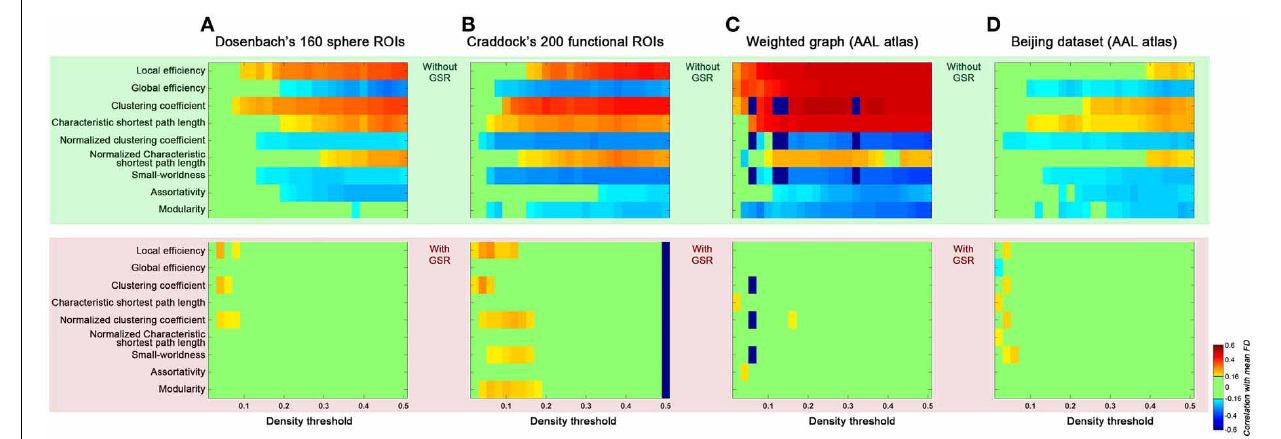
FIGURE 9 | Generalizability of the current findings of head motion dependencies. We addressed possible concerns regarding the generalizability of our findings to other studies by computing the topological parameters based on parcellation set ( A : Dosenbach’s 160